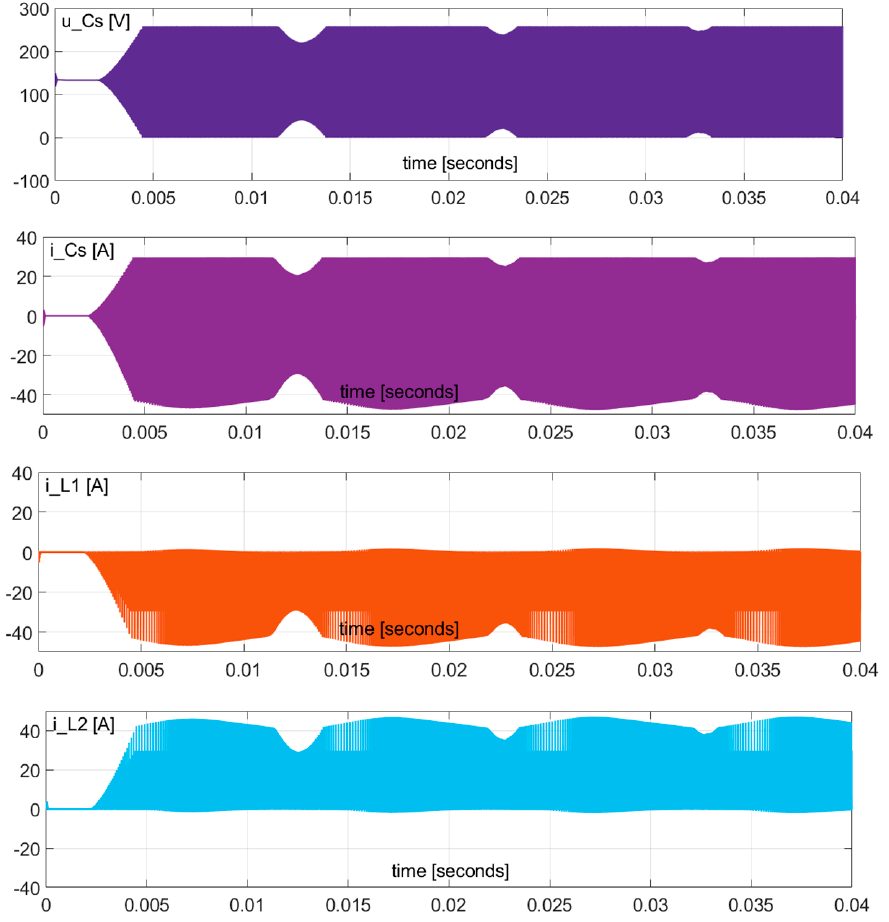
Figure 14. AIVB operation with variable frequency. Steady state waveforms of voltage and current of the switched capacitor as well as currents of resonant chokes. 5 ms/div. P out = 1 kW, L f = 6 uH.